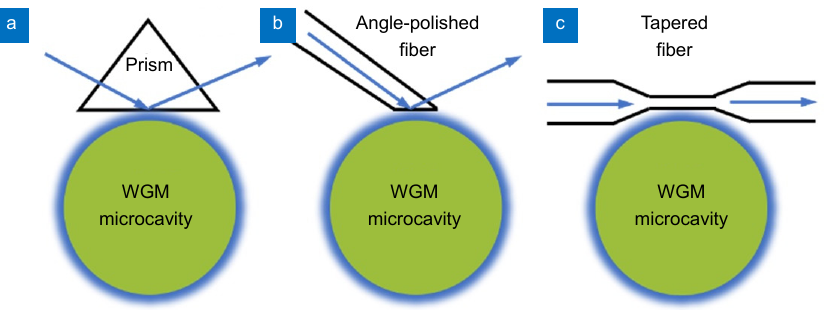
Fig. 2 | Different methods of exciting WGMs. (a) Prism coupling. (b) Polished fiber coupling. (c) Tapered fiber